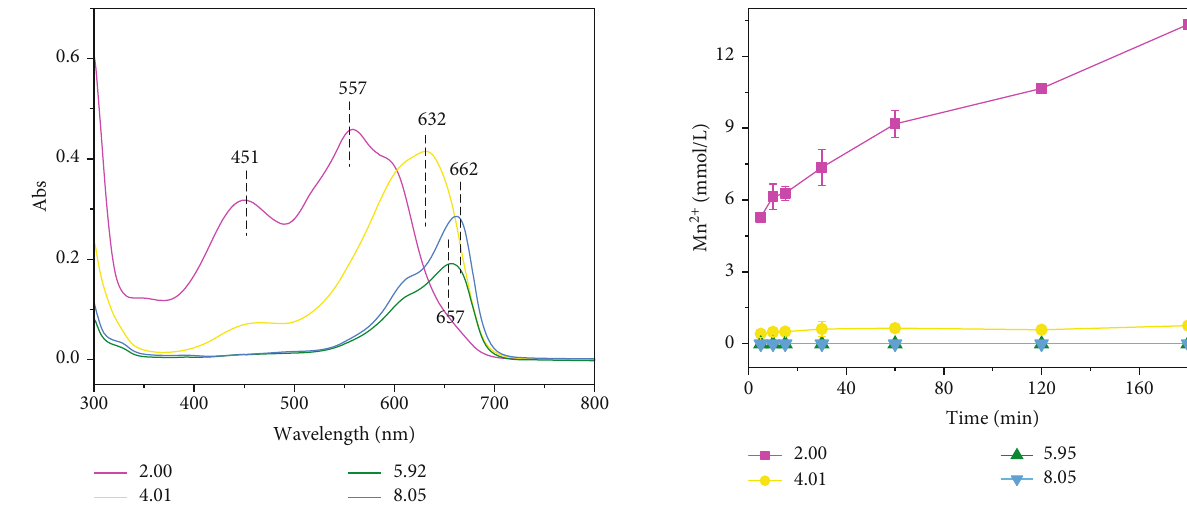
Figure 4: UV-Vis of MB after 3 hours of reaction at pH 2.00, 4.01 (dilute fi ve times), 5.92 (dilute ten times), and 8.05 (dilute ten